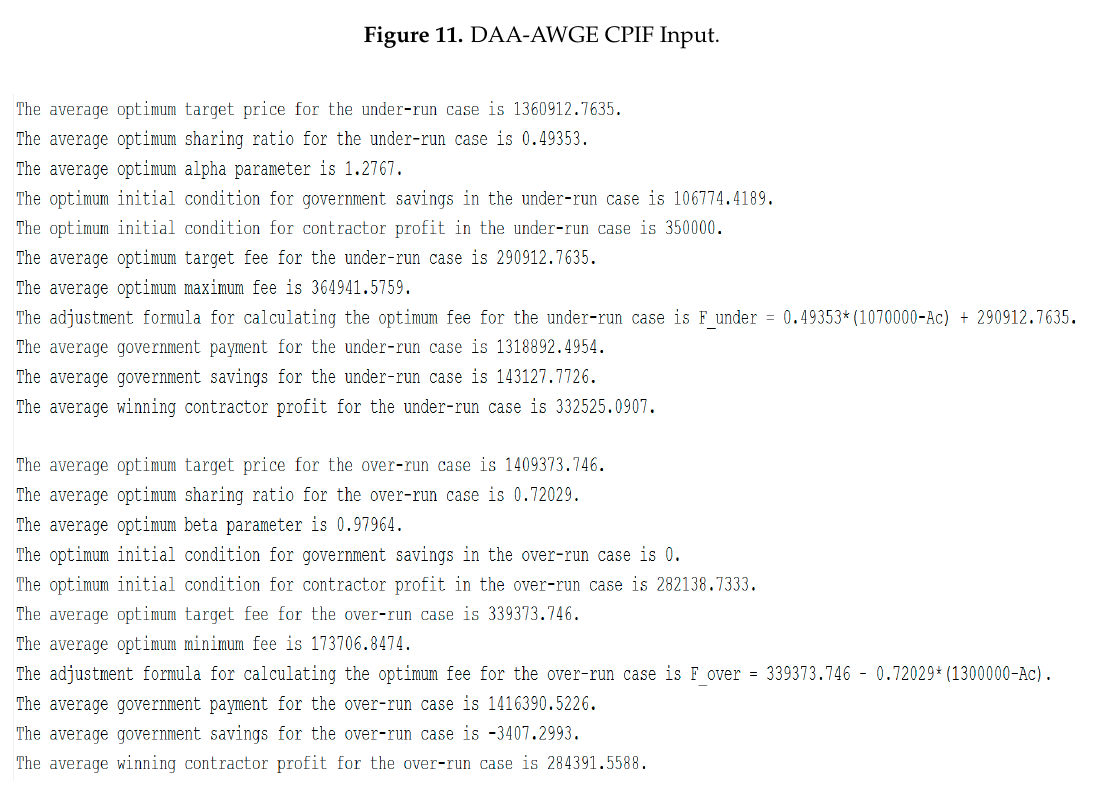
Figure 12. CPIF DAA-AWGE Output.